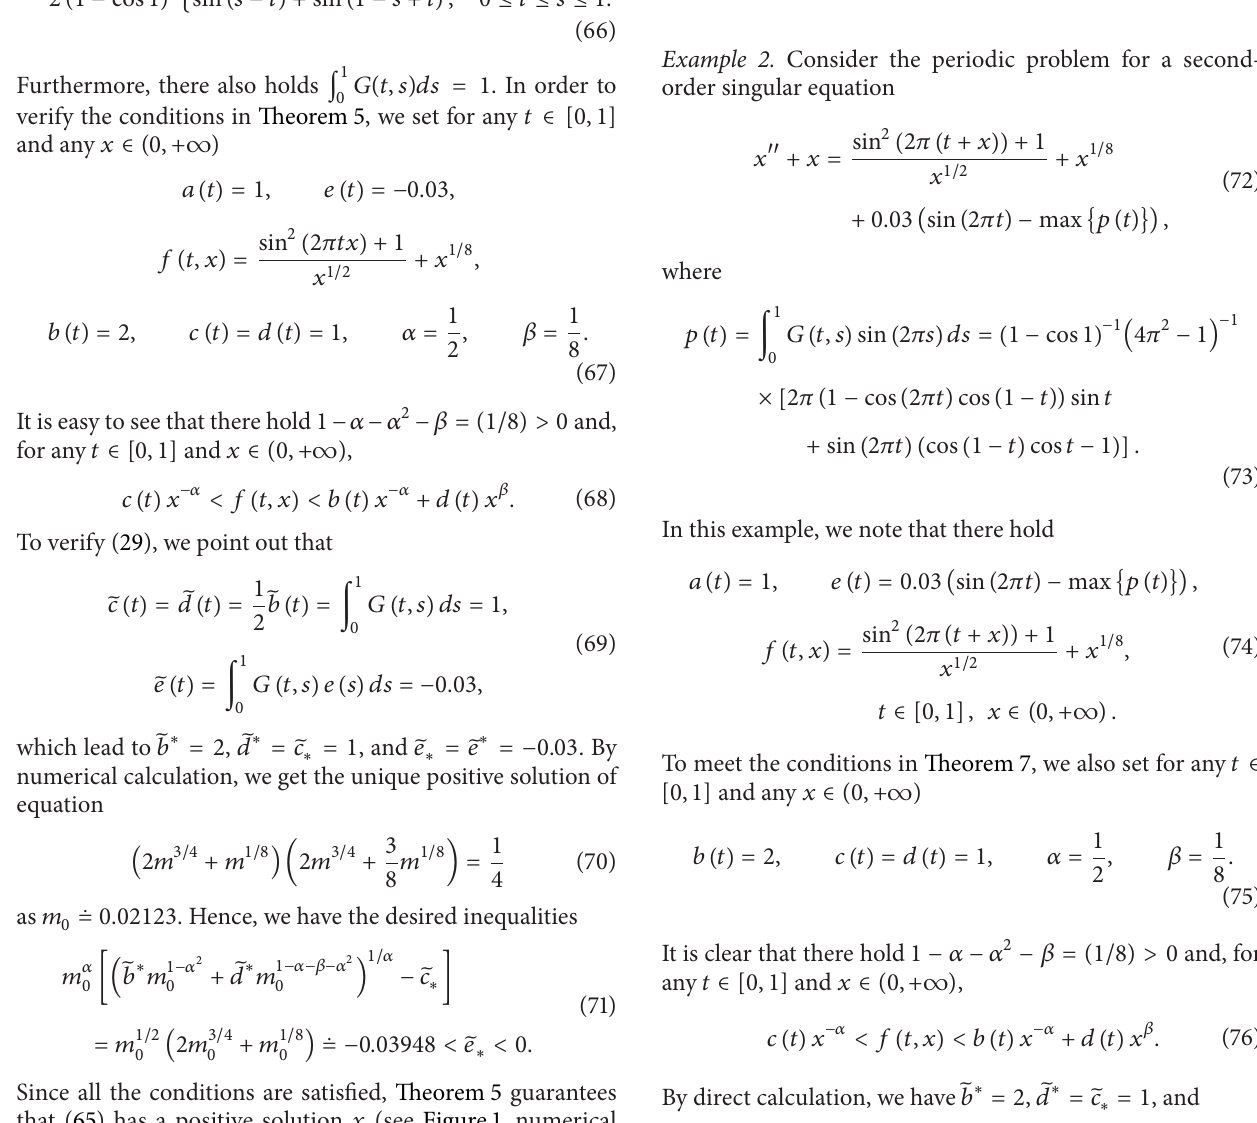
Figure 1: Numerical simulation for 𝑒(𝑡) = −0.03